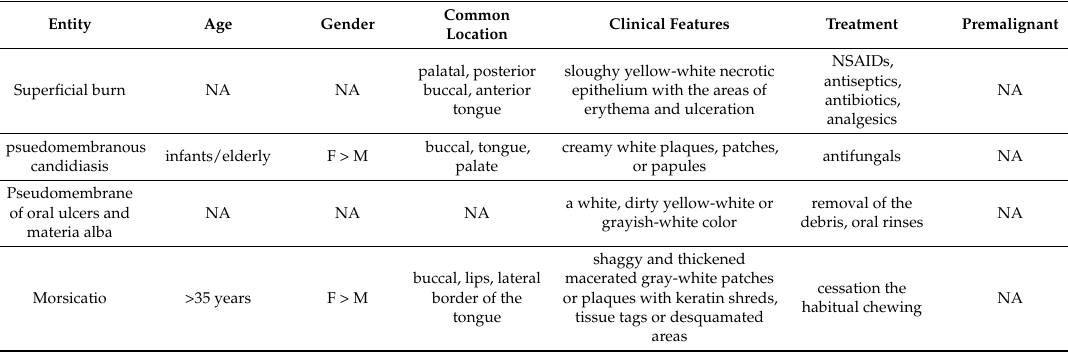
Table 2. Characteristics of acquired white lesions that can be scraped